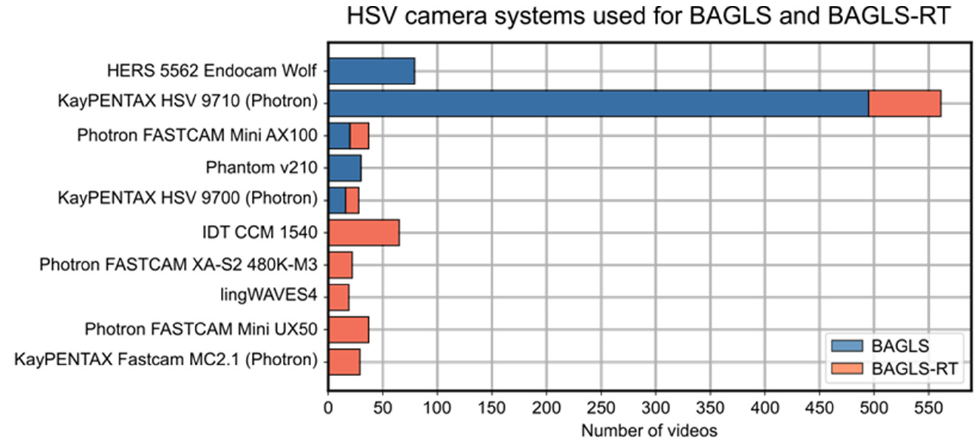
Figure 2. Overview of the considered camera systems and the number of corresponding videos in both data sets. Five new cameras are considered in the BAGLS-RT data set.